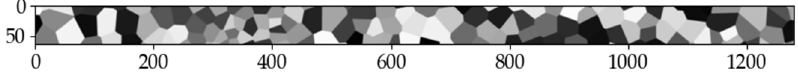
Figure 3. Exemplary 2 µm × 40 µm beam structure of Dataset 2.